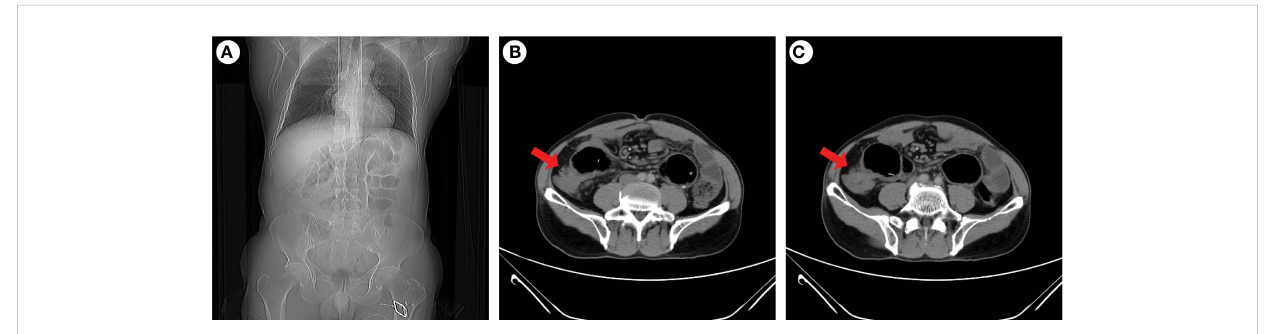
FIGURE 3 Abdominal CT examination of the patient when intestinal obstruction occurs again. Coronal images indicated gas and fl uid accumulation in the intestine (A) , and transverse images revealed ileocecal intestinal wall thickening (B, C) . The red arrow indicaes the ileocecal junction.